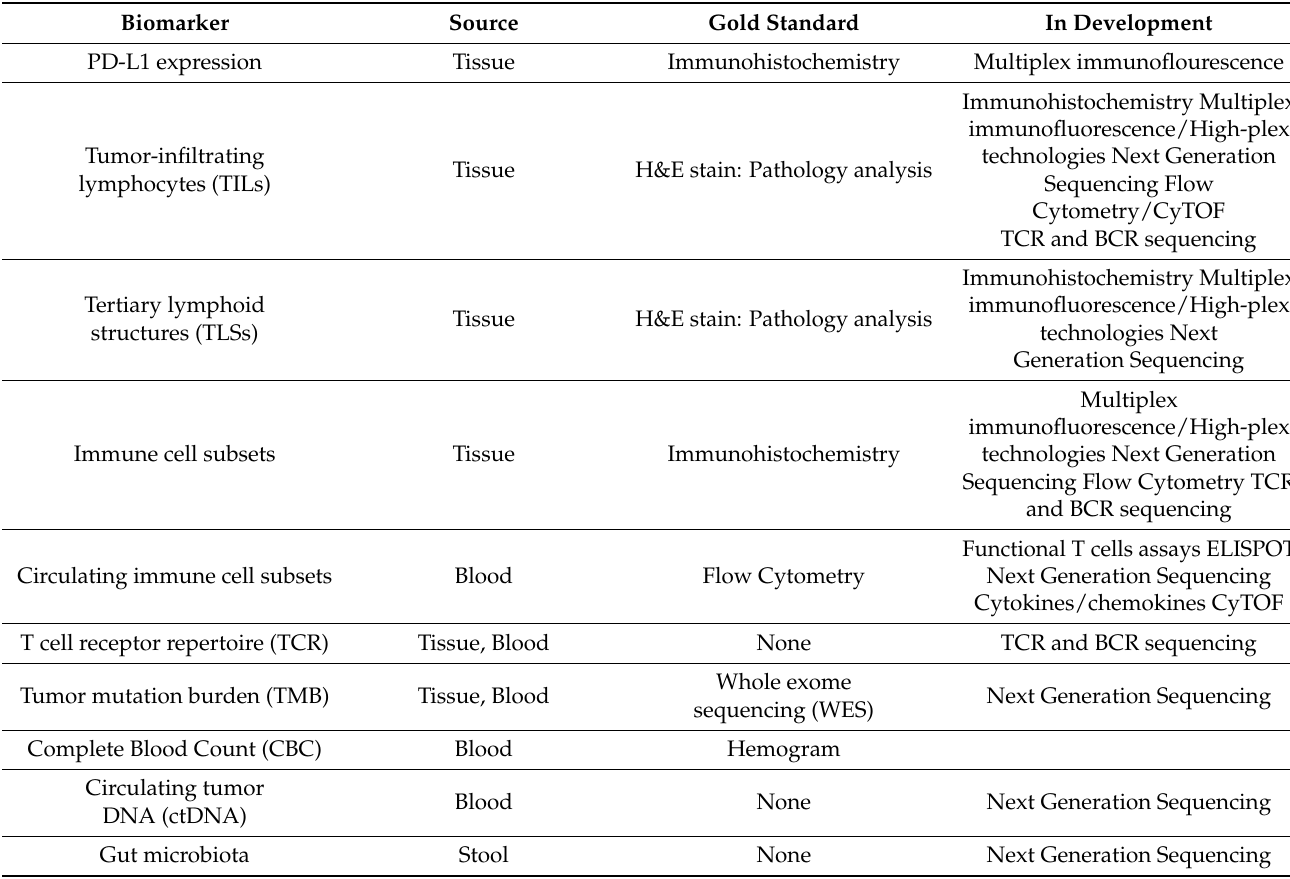
Table 2. Assays used to assess biomarkers in tissue, blood, and gut